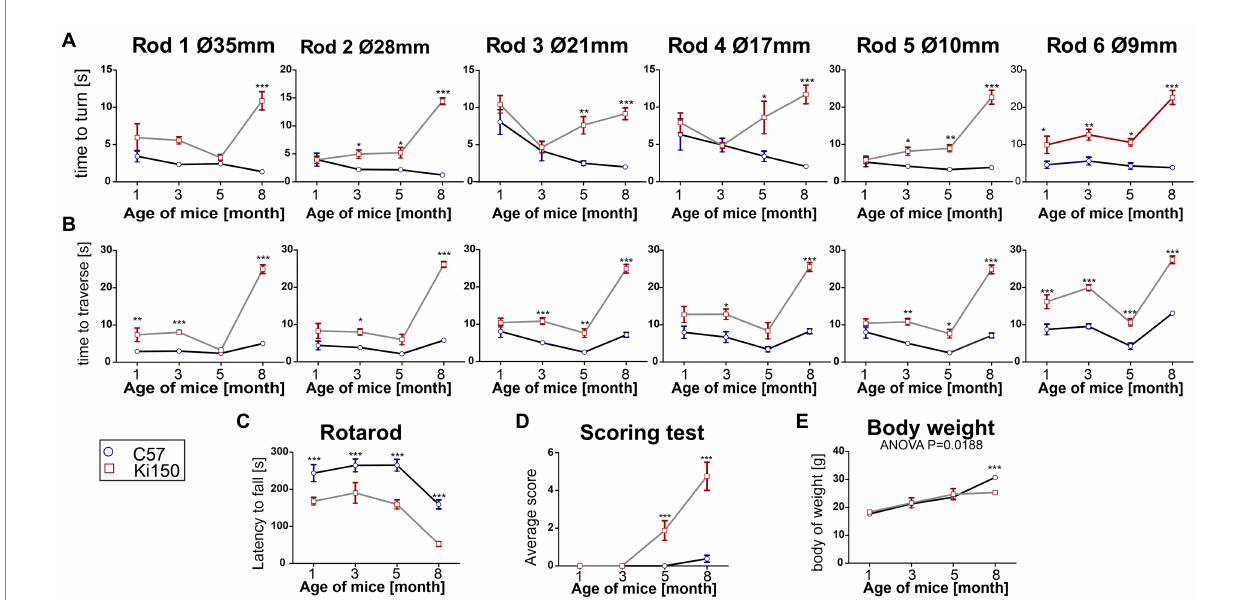
FIGURE 3 A progressive motor decline in Ki50 SCA3 knock-in model presents fast and severe phenotype. In the elevated beam walk test (A,B) “time to turn” and “traverse time” were measured on six rods with decreasing diameter (diameter of rods are indicated by Ø in mm). (A) One-month-old animals needed more time to turn on the rod 6 representing the highest level of difficulty and with disease progression more rods presented a challenge to Ki150 mice; Ultimately, at the age of 8 months Ki150 mice needed more time to traverse on all rods. (B) Similarly to the “time to turn” 1-month-old Ki91 mice needed significantly more time to traverse on rod 6, but also 1, whereas older 8-month-old mice needed more time on all rods. (C) Motor incoordination in accelerated rotarod (4–40 rpm in 5 min) was presented by Ki150 already at the age of 1 month. (D) In the scoring test, 5-month-old Ki150 mice presented SCA3 phenotype: incoordination, gait disturbances, kyphosis, and hind limb clasping. (E) The reduction of body weight gain in Ki150 was observed at the age of 8-month. Two-way ANOVA for every test besides body weight was p < 0.001. Two-way ANOVA with Bonferroni post hoc test ( p ≤ 0.05; total number of biological replicates: n = 16, n = 8 per genotype), error bars: SEM. Asterisks denotes a two-way ANOVA (* p < 0.05, ** p < 0.01, *** p <